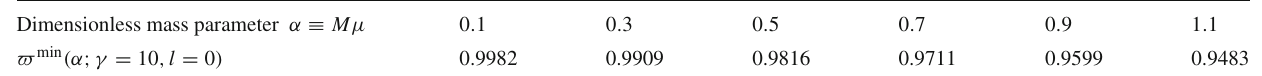
Onefindsthatthecharacteristicresonantfrequency (cid:16) min (α) ofthecom- posed star–field system is a monotonically decreasing function of the dimensionless mass parameter α . The resonant oscillation frequencies √ conform to the analytically derived bounds 1 − 2 M / R s < (cid:16) < 1 [see Eq. (16)]